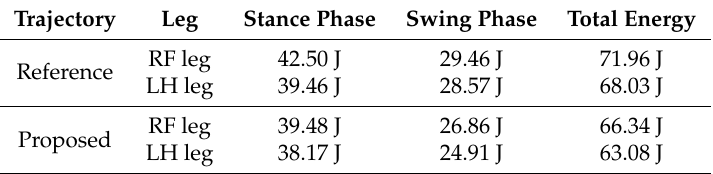
Figure 17. Foot trajectories of the RF leg in the SCalf prototype experiments. Table 7. The mean energy consumptions in physical